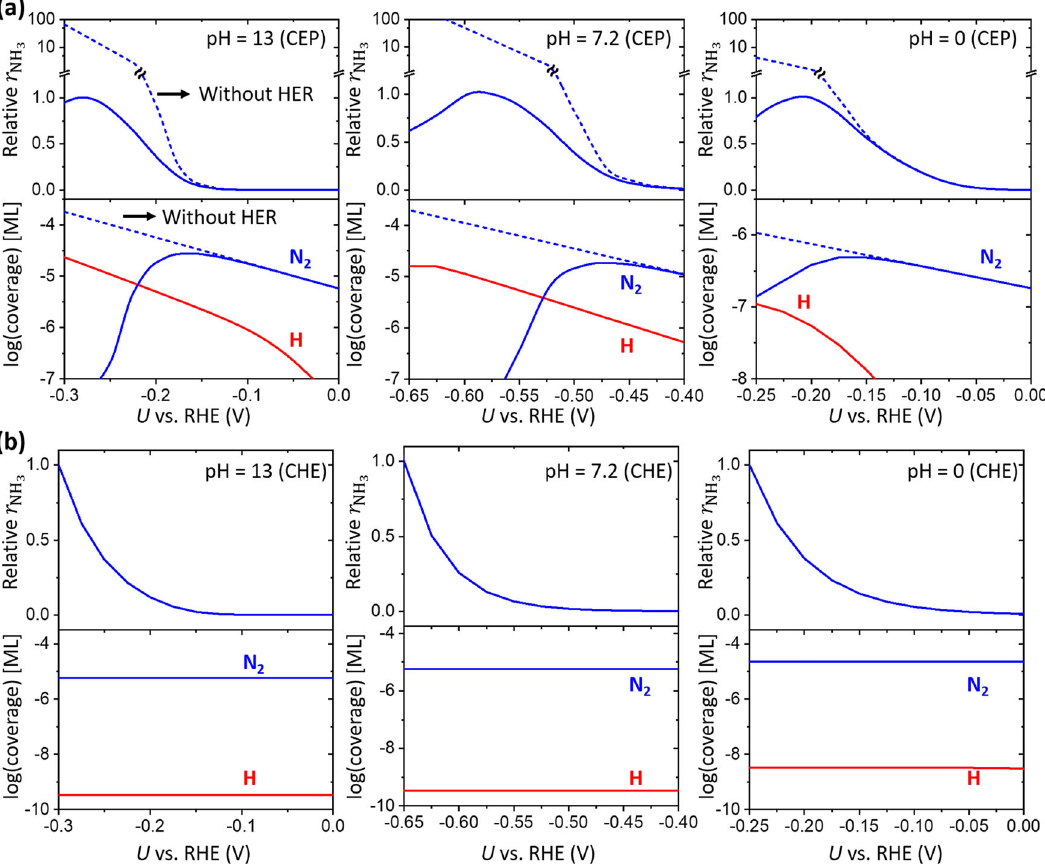
Fig. 6 The change in θ N , θ H , and r NH by U obtained by the MKM. a MKM results using the CEP model and b MKM results using the CHE model at three 2 3 different pH (pH = 13, 7.2, and 0). The relative r NH is obtained by dividing the r NH 3 relative r NH and coverage are shown in upper and lower panels, respectively. 3